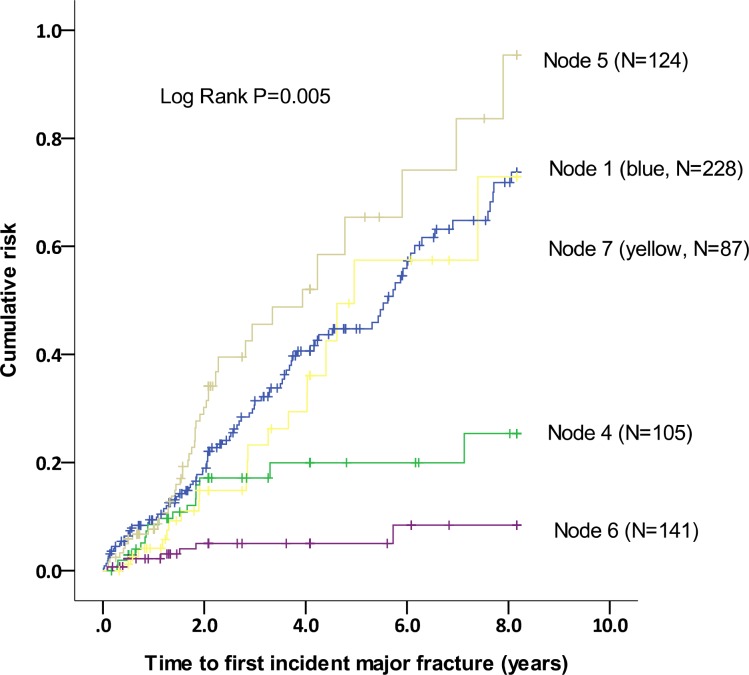
Kaplan-Meier survival curves for all patients, by risk group.Node 1: within fetuin A tertile 1, with or without VC; node 4: within fetuin A tertile 2, without VC; node 5: within fetuin A tertile 2, with VC; node 6: within fetuin A tertile 3, without VC and node 7: within fetuin A tertile 3, with VC.